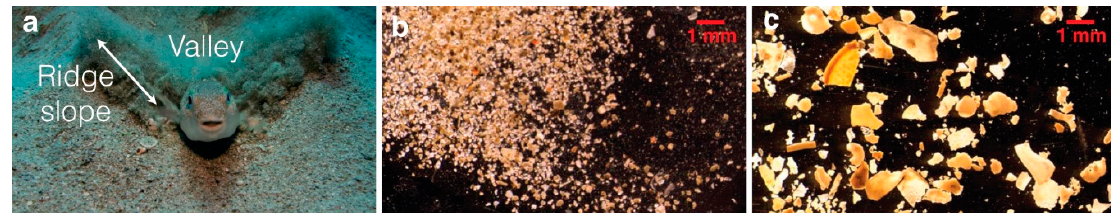
Figure 2. Sand particle deposition during excavation of the nest. ( a ) Male pufferfish is moving through a valley while digging the sand using its pectoral, anal and caudal fins. This results in the stirred-up sand particles depoingsit on either side of the valley surface; ( b ) Photomicrograph of sand particles collected from a nest site the day before spawning; ( c ) Photomicrograph of sand particles collected from a nest site the day before hatching. ( a ) still image modified from [7]; ( b ) and ( c ) modified from [4].